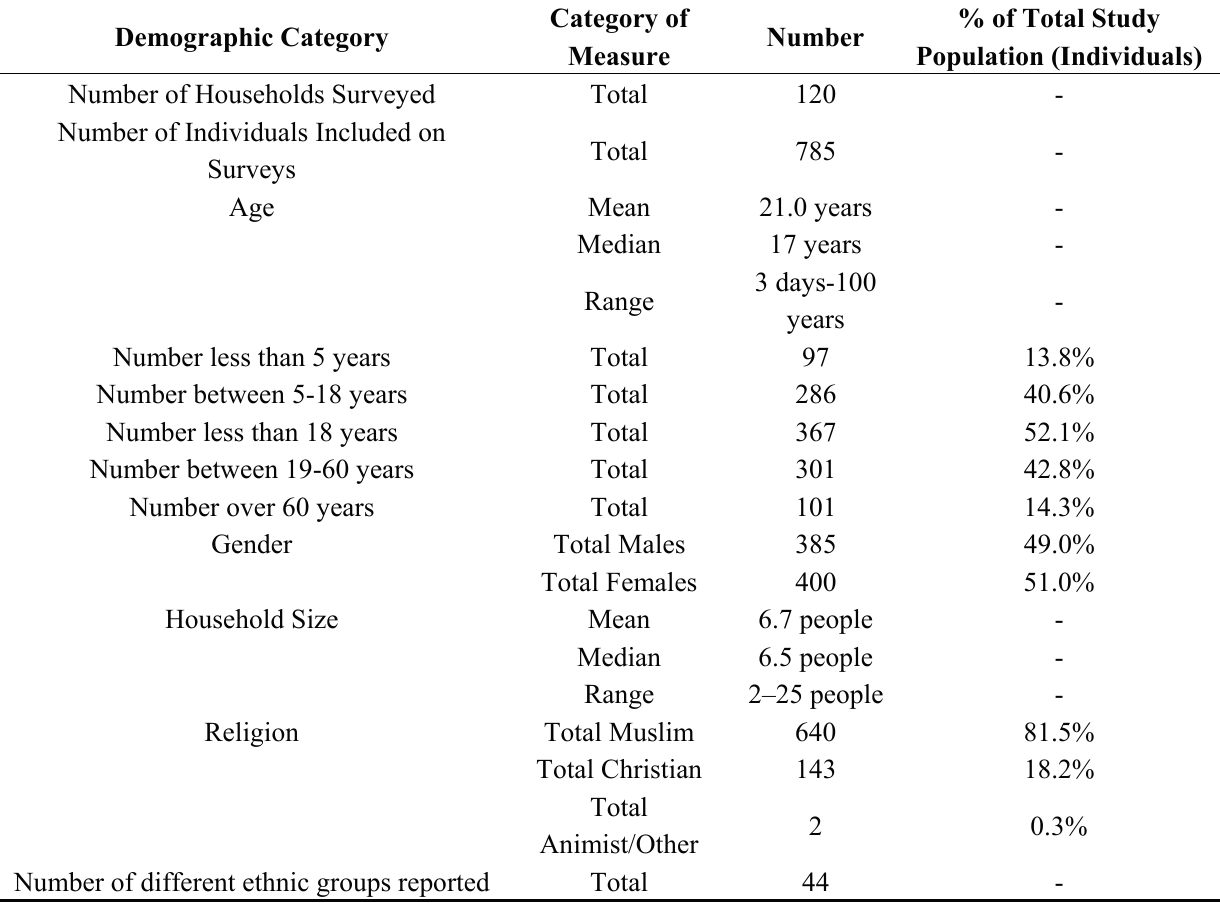
% of Total Study Category of Number Population (Individuals) Measure